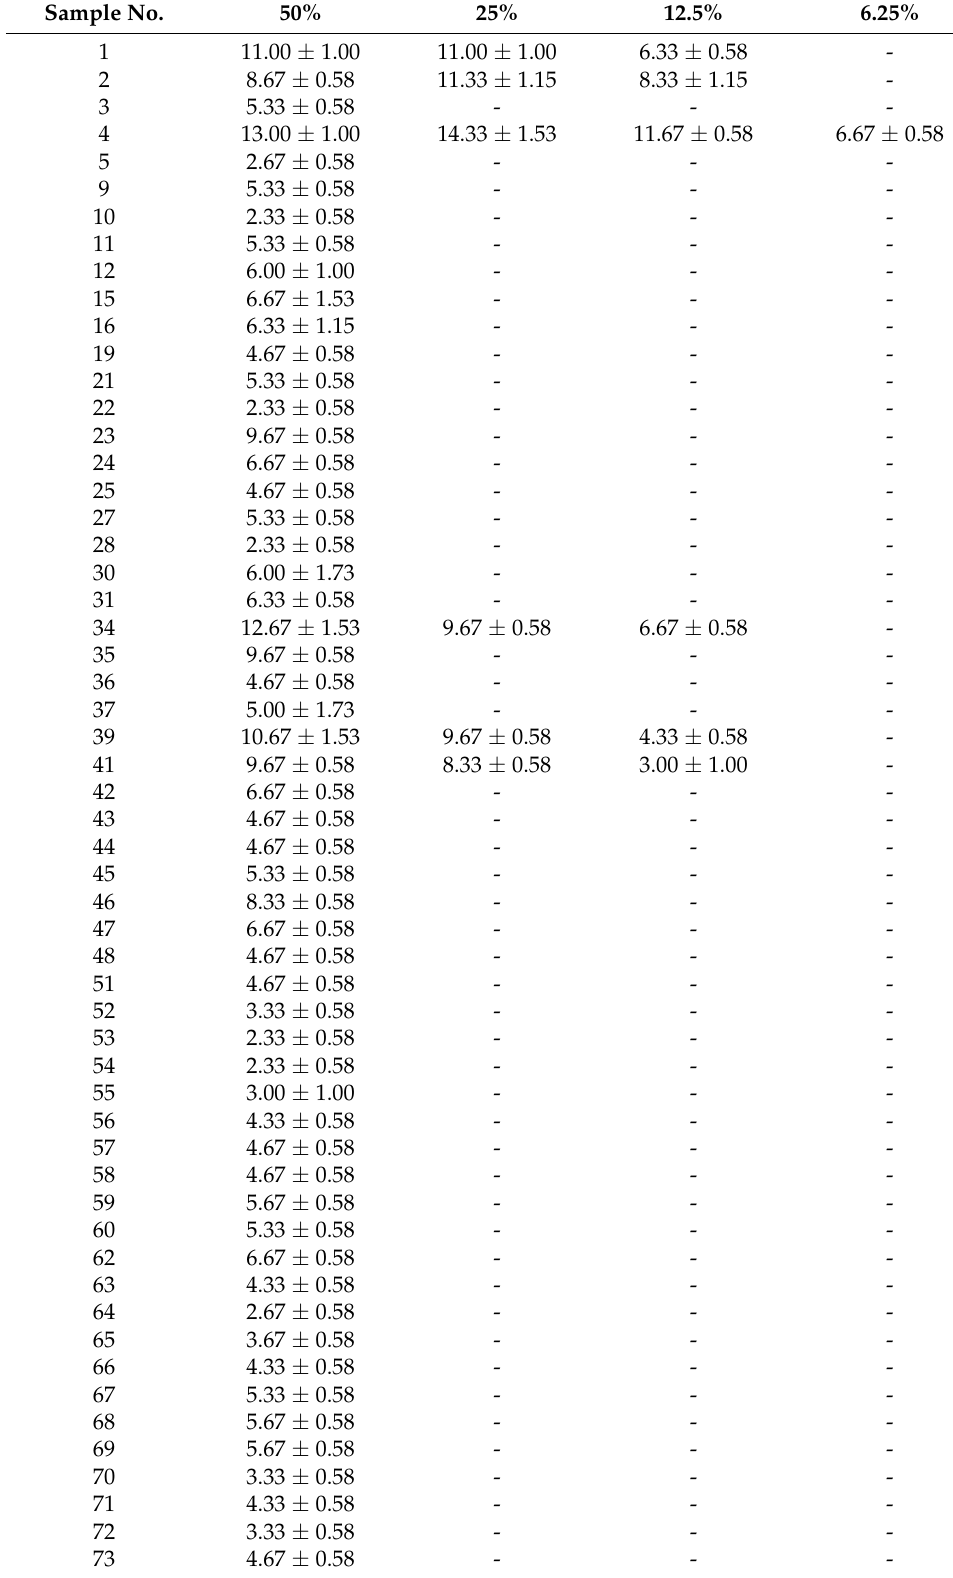
Table 6. Antimicrobial activity of samples against B. subtilis in mm. Sample